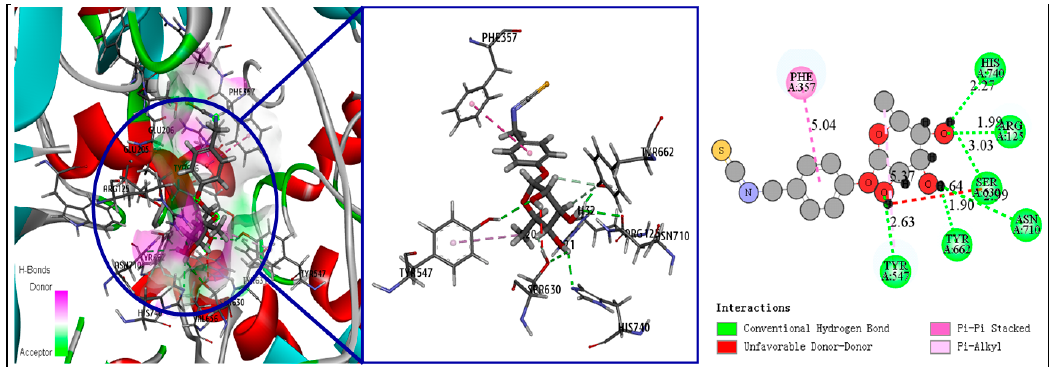
Figure 4. Receptor–ligand interaction of compound 2 with DPP-IV binding site.